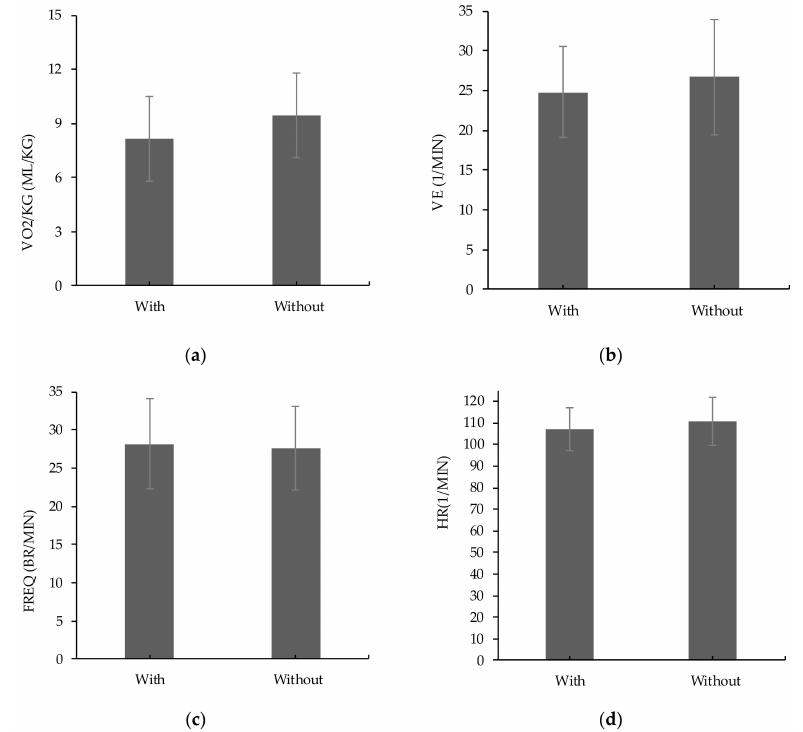
Figure 2. The mean values of normalized oxygen consumption (VO2 / kg, ( a )), minute ventilation (VE, ( b )), respiratory rate ( c ), and heart rate (HR, ( d )) with and without wearing the aid. Error bars represent standard deviation